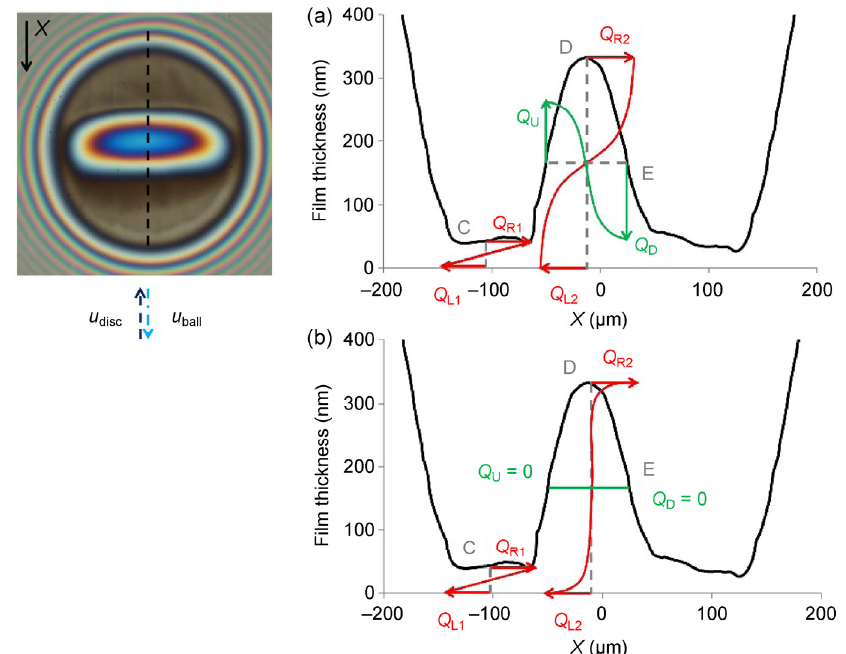
Fig. 5 Illustration of speed profiles in the contact under pure opposite sliding (a) with and (b) without through-film lubricant